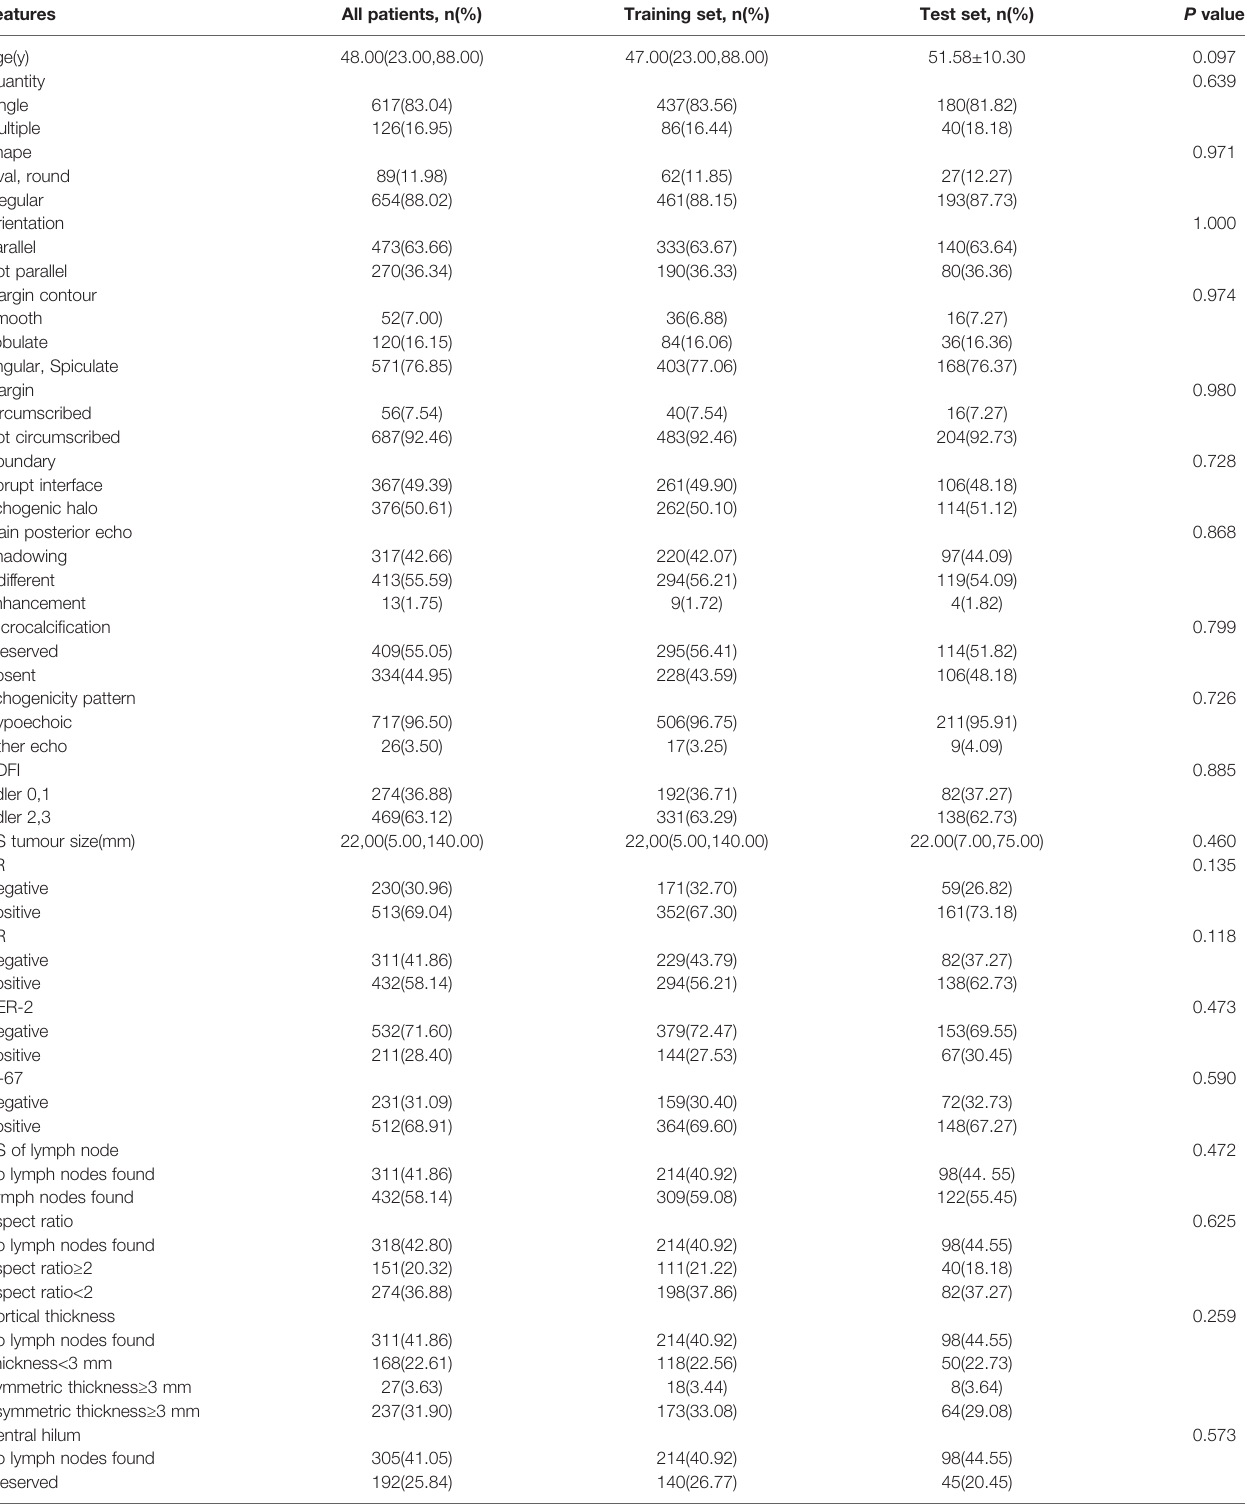
TABLE 1 | Patients: all patients, patients according to training set or test set and comparison of the composition ratio between groups.